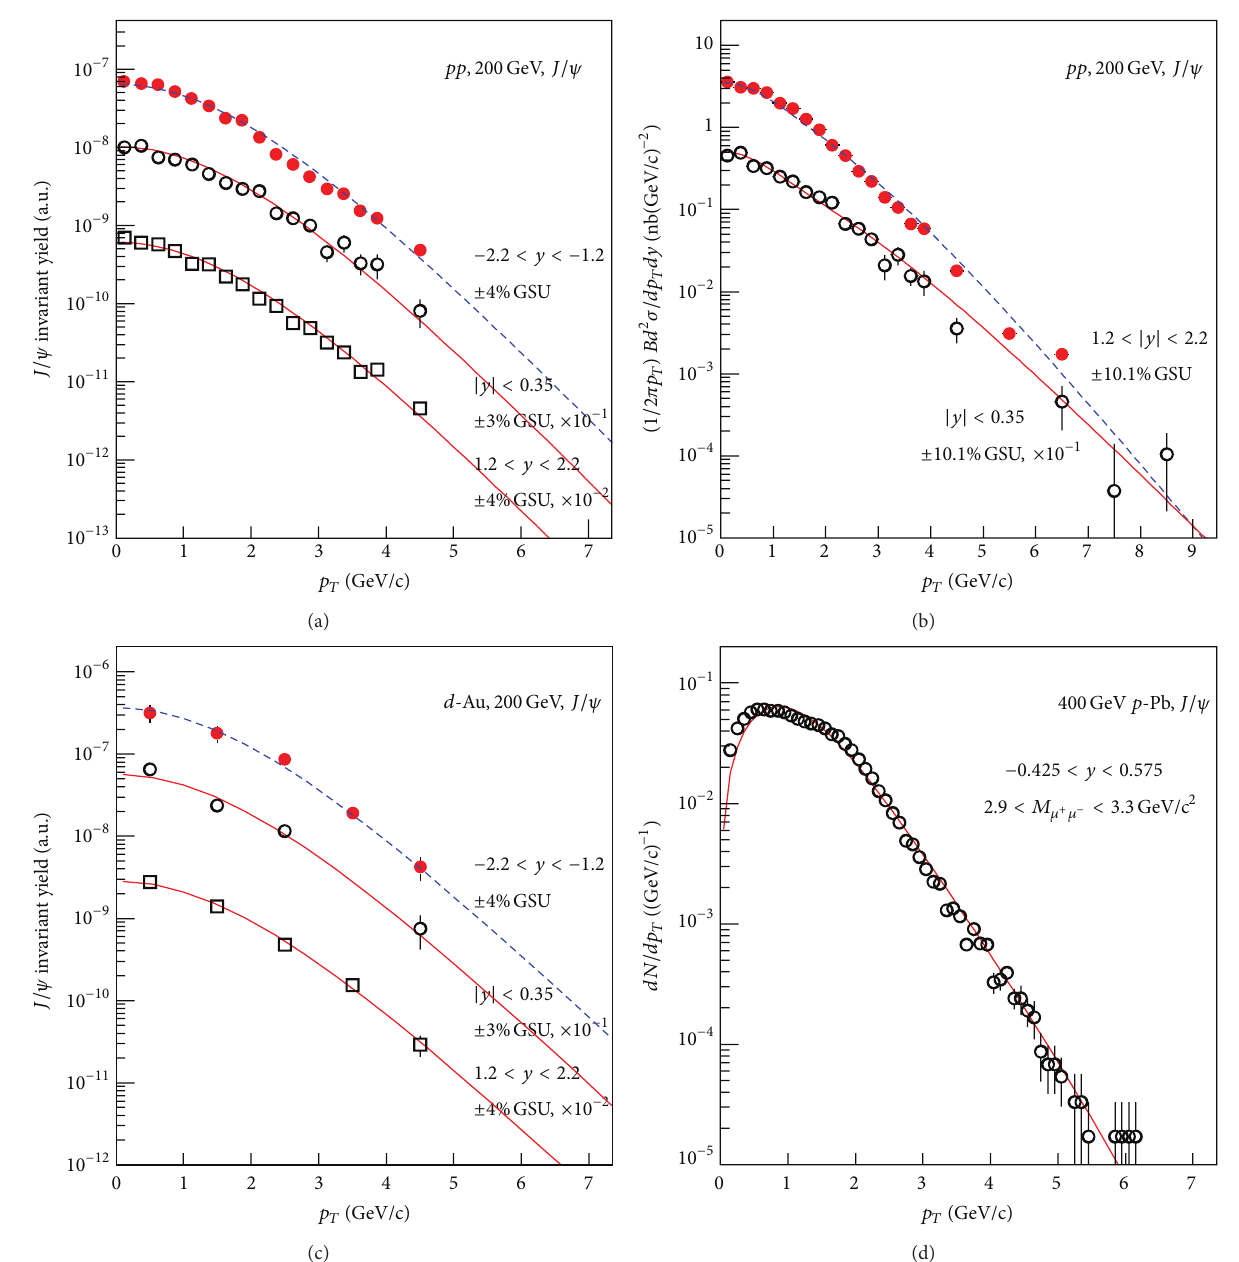
Figure 2: The transverse momentum distributions of 𝐽/𝜓 produced in (a) and (b) 𝑝𝑝 collision at √𝑠 = 200 GeV, (c) d -Au collisions at √𝑠 = 200 GeV, and (d) p -Pb collisions at beam energy being 400GeV with different y ranges, GSU (or 𝑀 𝑁𝑁 are shown in the figure. The symbols represent the experimental data of the PHENIX [28–30] and NA50 Collaborations [31] and the curves are our results calculated by the Boltzmann or two-component Boltzmann